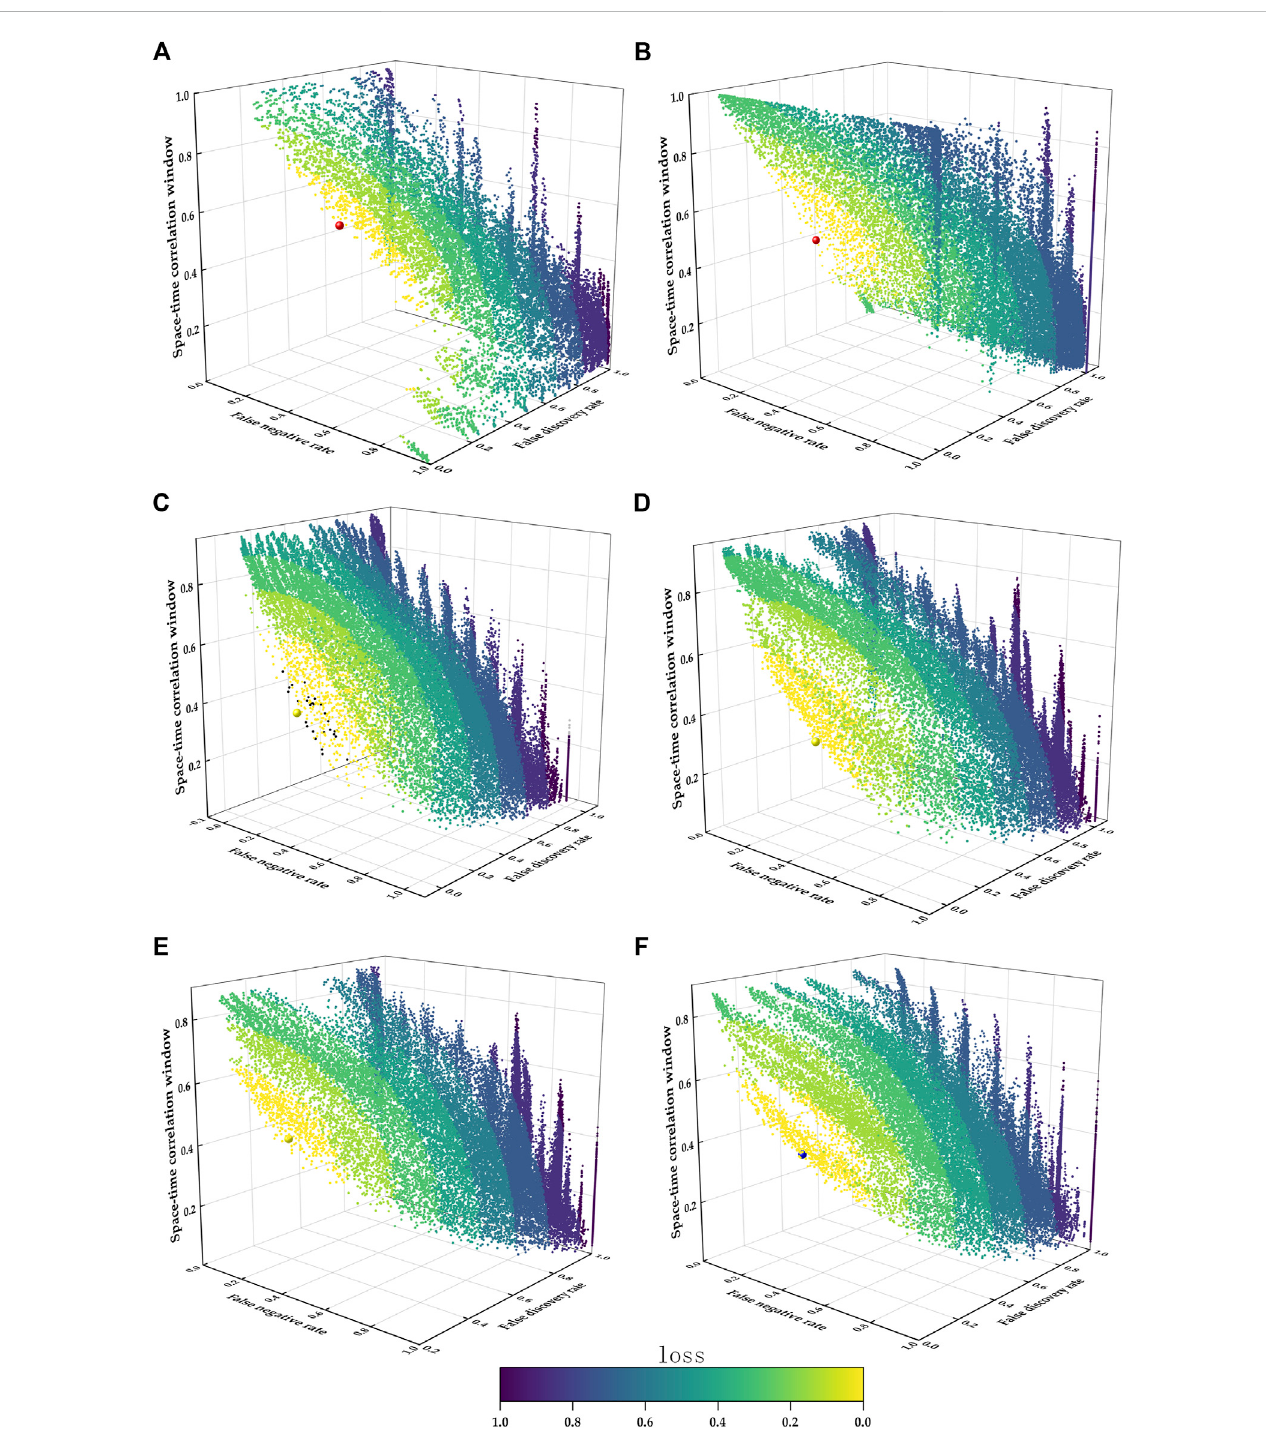
FIGURE 6 Theresultofthebestparametersformethods. (A – F) representtheoptimalparametersofeachmethodtotheoveralltrainingstep[ (A) :AE, (B) IF, (C) IQR, (D) WT, (E) RST, (F) Kalman].The x -axisand y -axisofthediagramarethefractionofspace-timeoccupiedbyalarmsandtheFNR,respectively, andthe z -axisis the FDR (FDR= 1-PPV). The symbol marked by red, yellow, and blue are the parameter sets with the lowest Loss m